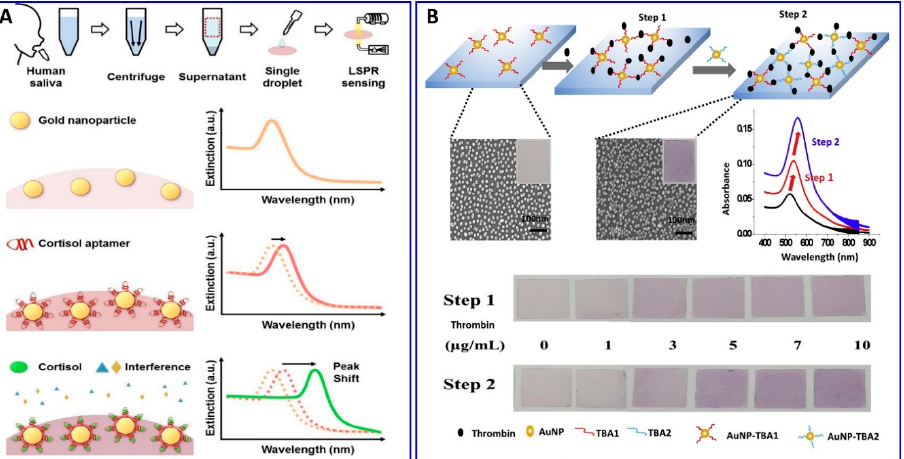
Figure 3. ( A ) Schematic illustration of the cortisol assay based on localized surface plasmon resonance (LSPR) aptasensor, reproduced from [99]. ( B ) Scheme representing the thrombin assay via sandwich colorimetric solid-phase aptasensor based on the enhanced LSPR, reproduced from [100].